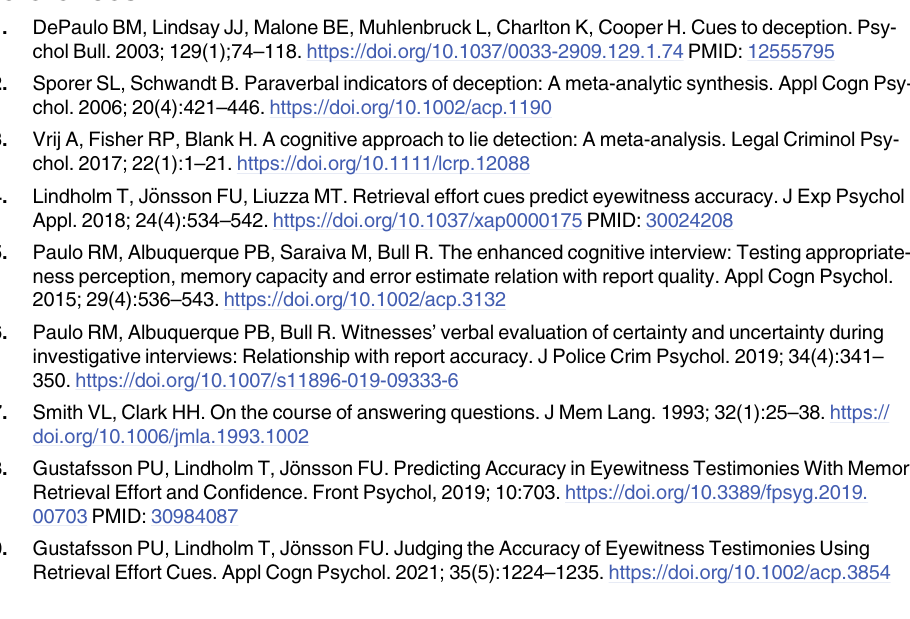
S2 Fig. Effects of accuracy, time and repetition on confidence and the retrieval-effort index in free and cued recall.